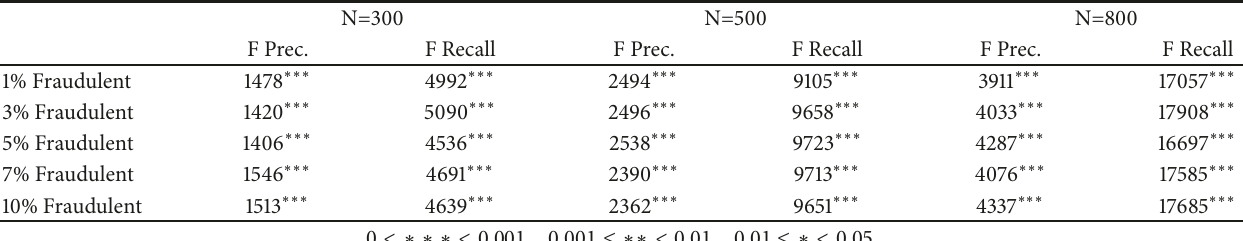
Table 8: The result of one-way repeated measures ANOVA for the second design. N=300 N=500 N=800 F Prec.